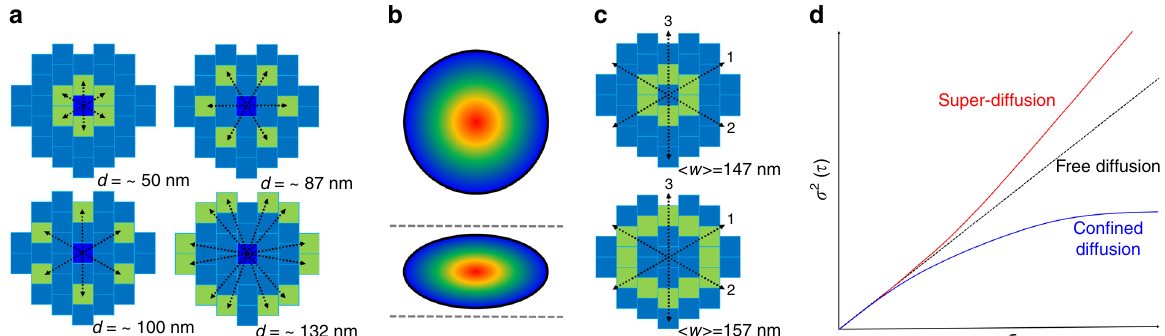
Fig. 2 a Schematic of the pixels used for computing the 2D pair correlation function. The cross-correlation is computed between the central pixel (blue) and the highlighted pixels (green), the 2D-pCF can be computed at four different distances, stated next to the relative con fi guration. b Schematic example of 2D-pCF in the case of diffusion without barriers (top) and with barriers (bottom) affecting the diffusion of the probe. c Schematic showing the location of the detectors used (green) for the iMSD analysis in ring 1 (top) and ring 2 (bottom). The measured average waist relative to each con fi guration is shown in the fi gure. Dashed black arrows refer to the direction along which the spatiotemporal correlation is computed. d Schematic of the iMSD principle. The fi tted variance of the spatiotemporal correlation function increases linearly in the case of free diffusion (dashed black line) and bends upwards or downwards in the case of super-diffusion (solid red curve) or con fi ned diffusion (solid blue line),